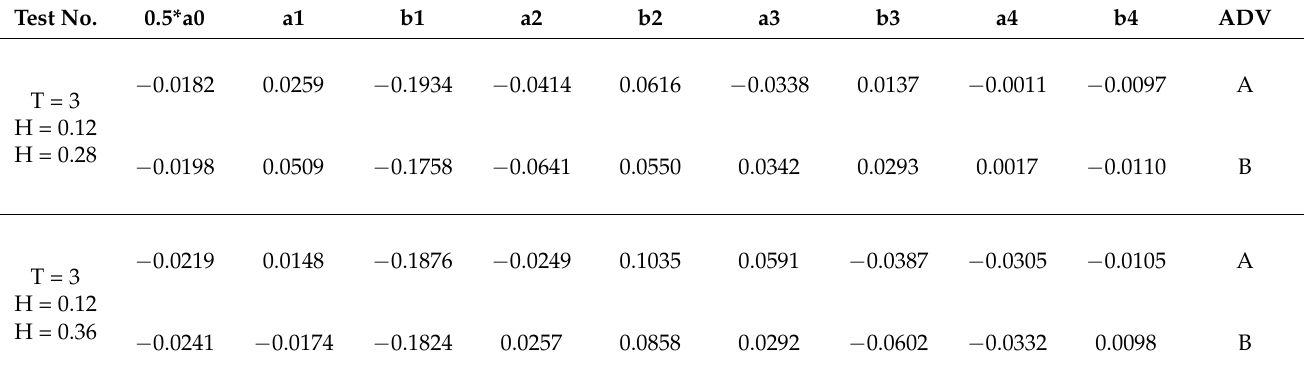
Table 5. Summary of Fourier series coefficients used as inputs to the numerical